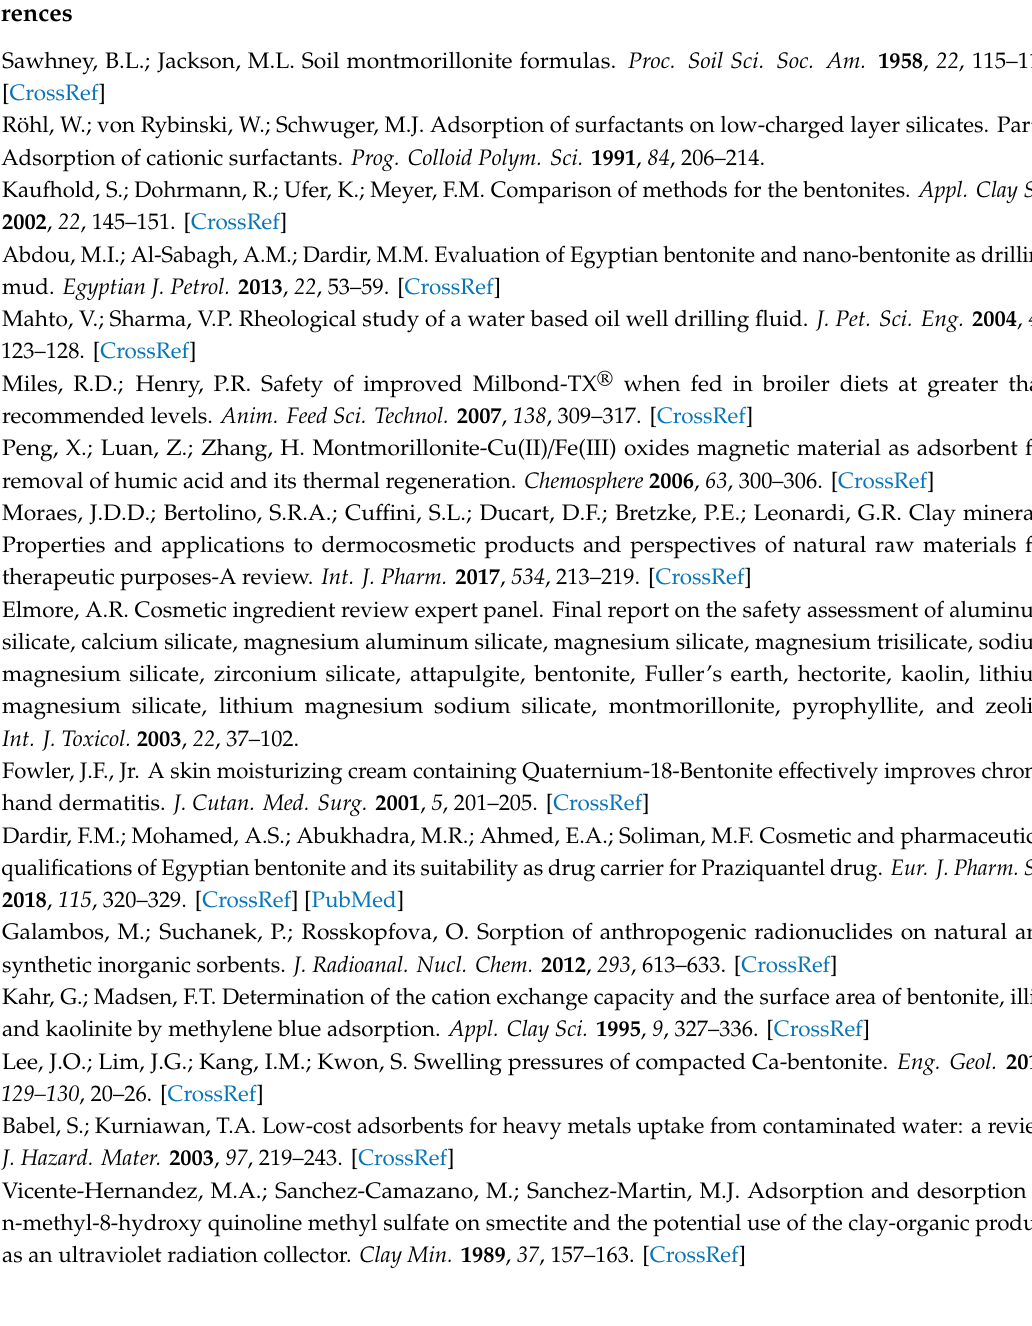
Table S1: Bodyweight and food intake. Table S2: Primers used for RT-PCR analysis. Table S3: Composition of the experimental diets. Figure S1: In vivo biochemical